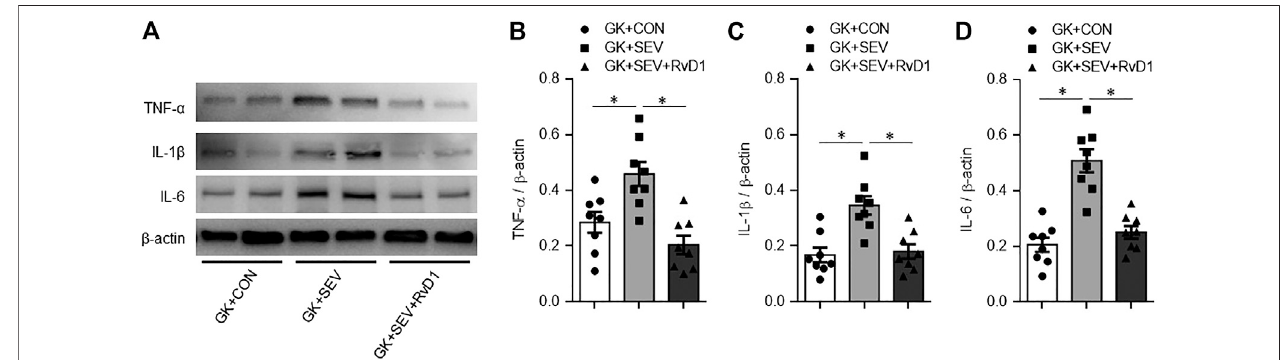
FIGURE3| RepresentativeWesternblots (A) andquantitativecomparisonofproteinexpressionforpro-in fl ammatorycytokinesTNF- α (B) ,IL-1 β (C) andIL-6 (D) in the hippocampus in type 2 diabetic Goto-Kakizaki (GK) rats after control (CON) or sevo fl urane (SEV) exposure and in exogenous RvD1-treated GK rats after SEV exposure. Data are presented as mean ± SE (n (cid:1) 8 for each group). * p < 0.05.